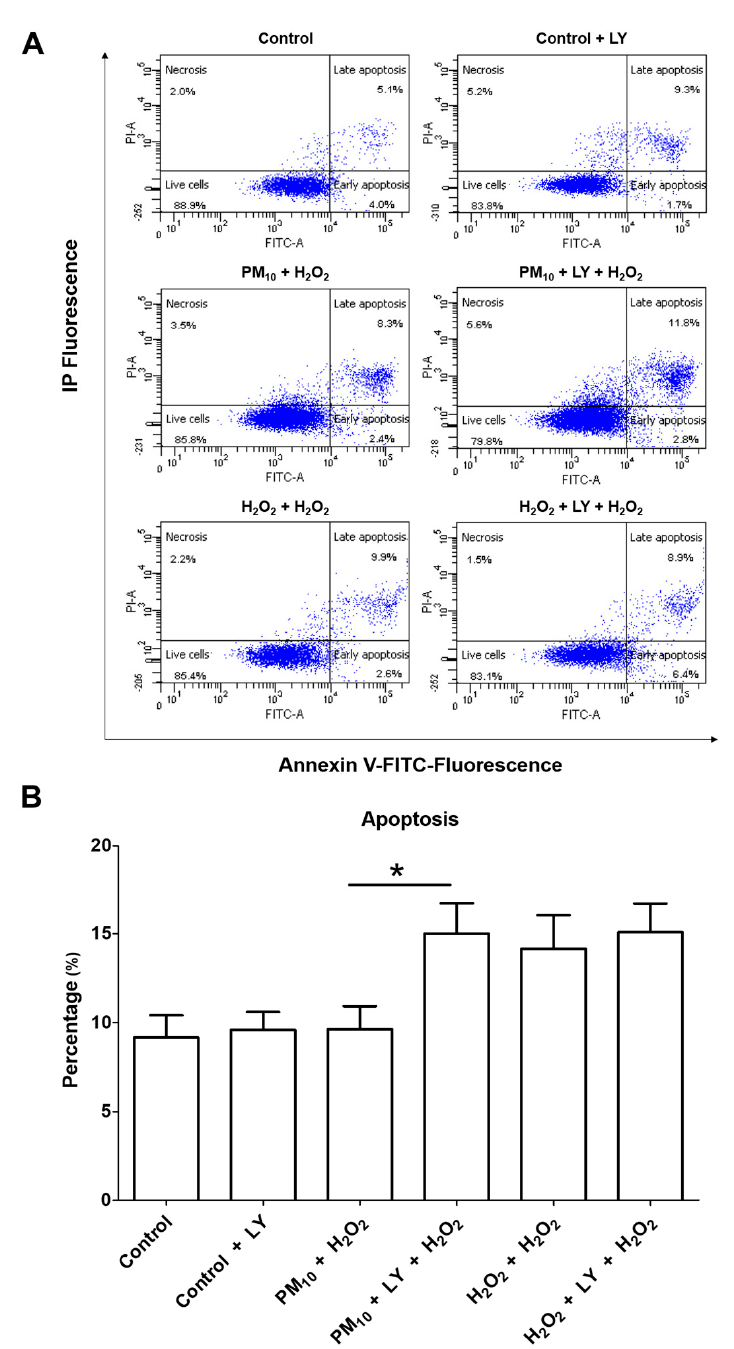
Figure 7. Representative plots ( A ) and graphic ( B ) of apoptosis evaluation of cells pre-exposed to PM 10 (10 µ g / cm 2 ) for 24 h and then treated with H 2 O 2 (500 mM) for 24 h. LY294002 inhibitor (LY) (50 µ M) was incubated for 1 h prior to H 2 O 2 (500 mM) treatment. ( B ) Bar graph showing the average percentage of apoptotic cells pre-exposed to PM 10 (10 µ g / cm 2 ) for 24 h and then treated with H 2 O 2 (500 mM) for 24 h. LY294002 inhibitor (50 µ M; indicated in bar 2, 4, and 6) was incubated for 1 h prior to H 2 O 2 (500 µ M) treatment (lane 3 and 6). Treatments with LY294002 were incubated with LY294002 inhibitor (50 µ M) 1 h before the H 2 O 2 (500 µ M) treatment. Cells were stained with Annexin V dye and propidium iodide and analyzed by a flow cytometer. * p < 0.01 versus PM 10 + H 2 O 2 . The image is representative of three independent experiments, and values are the mean ± SD of three independent